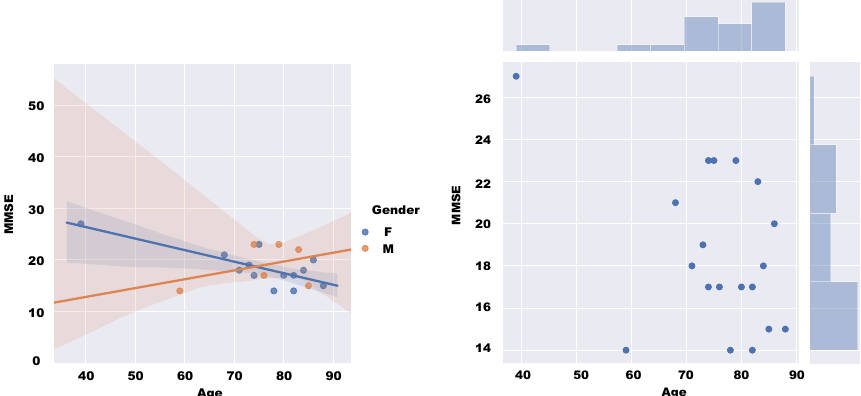
Figure 6. Distribution of subjects by score on the MMSE, and its relationship with age and gender. ( left ):gender distribution; ( right ): age